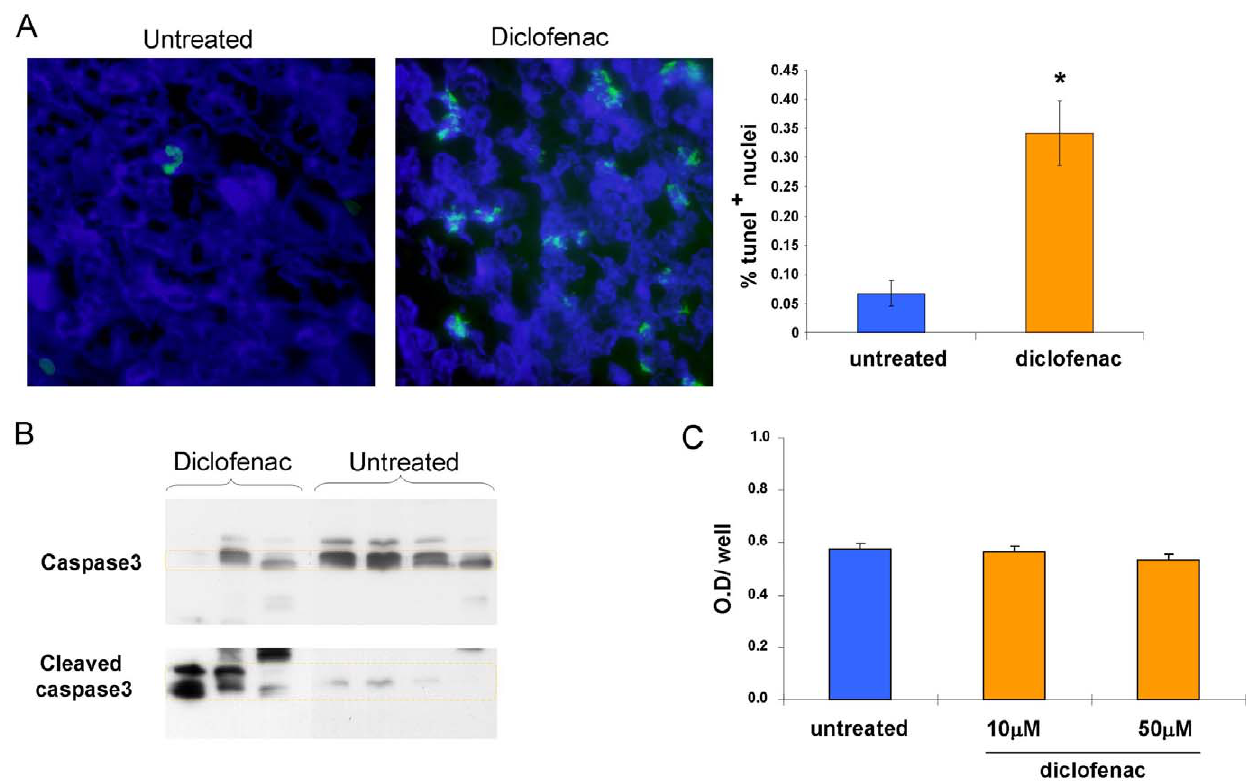
Figure 2. Diclofenac increases apoptosis of tumor cells invivo but not invitro . A and B, mice were inoculated with PANC02 cells and treated with diclofenac as described in Figure 1. A, lef t, TUNEL staining superpositioned over DAPI staining of fixed tumors, right , mean 6 SE % of TUNEL positive nuclei out of DAPI stained nuclei. About 9000 nuclei from tumors of 4 untreated and 4 diclofenac treated mice were counted * P # 0.001. B, Caspase-3 activation in tumor homogenates of 4 untreated and 3 diclofenac treated mice was measured as described in Materials and Methods, one out of two experiments. C, PANC02 (3000 cells/well) were seeded in 96-NUNC wells. The day after seeding 10 or 50 m M diclofenac was added and cells were incubated for additional 4 days. The number of cells was measured using a Cell Proliferation Kit. Mean 6 SE of OD of 6 wells in each group. One experiment representative of 3.